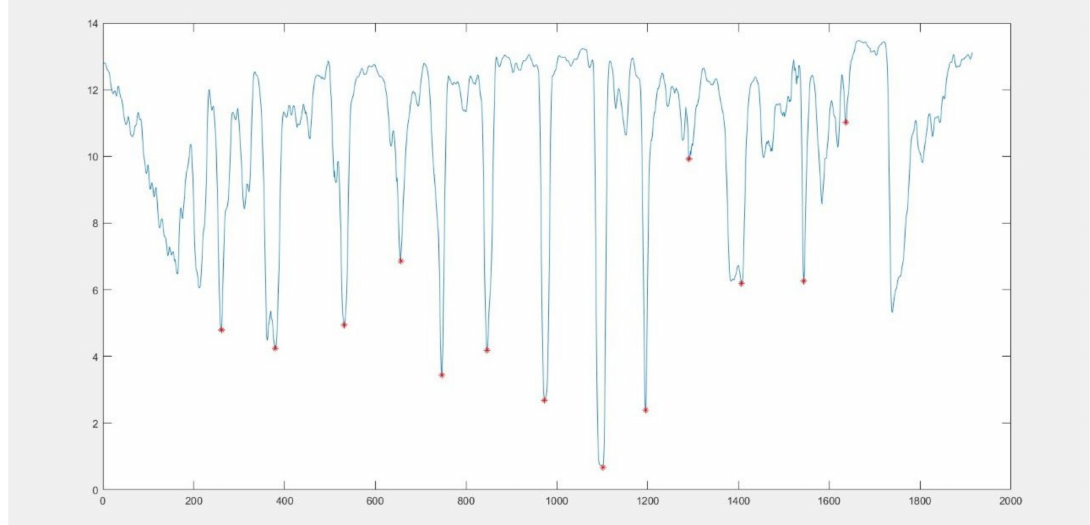
Figure 14. The pixel